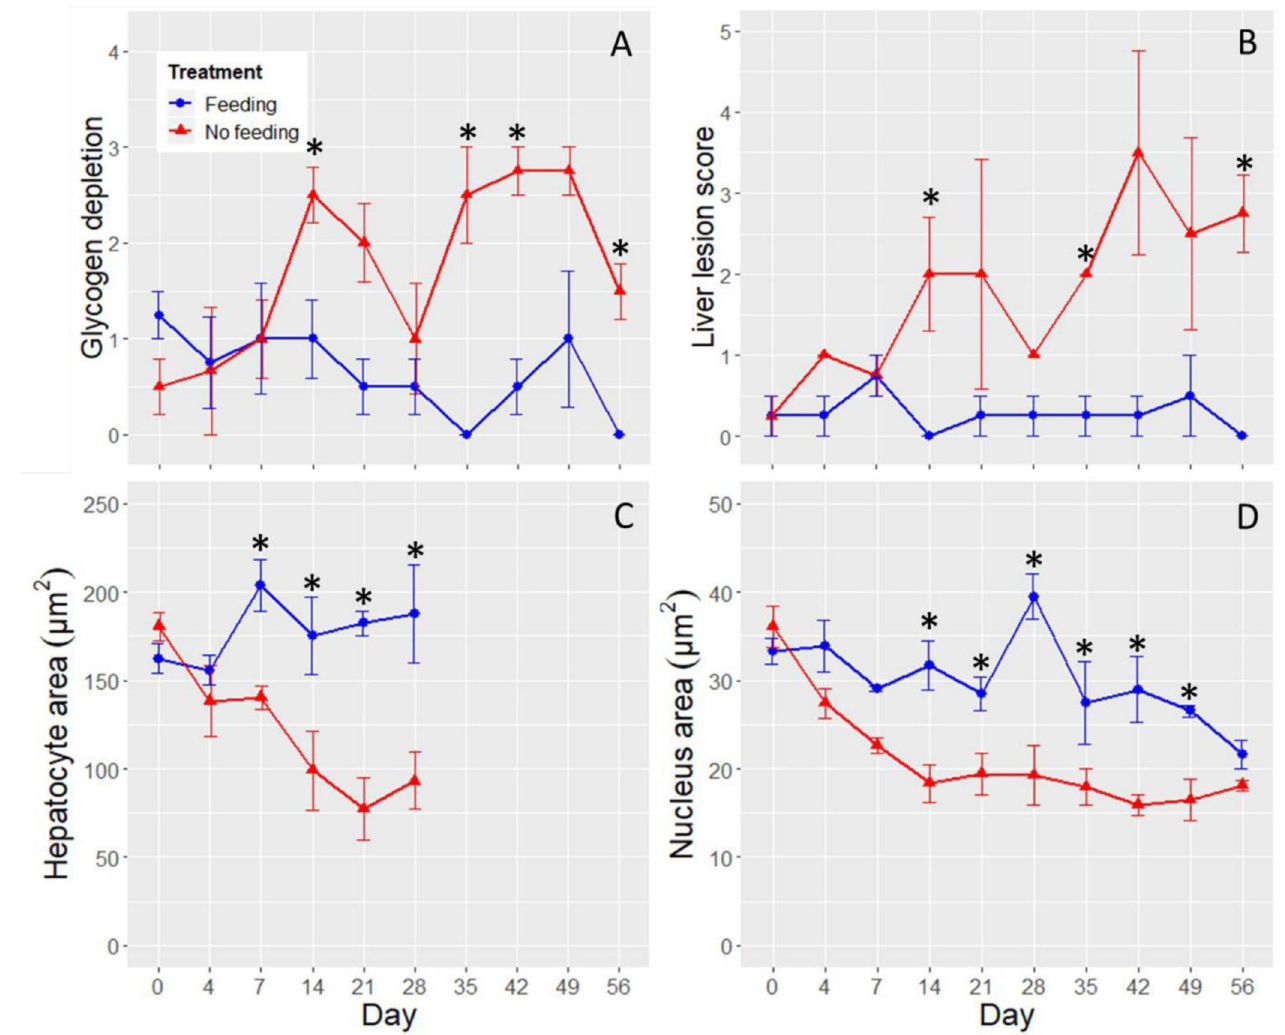
Fig 5. Histological indices by day. Panel A is glycogen depletion, panel B is liver lesion score, panel C is hepatocyte area, and panel D is nucleus area for the Feeding treatment (blue circles) and the No Feeding treatment (red triangles). The stars denote the time points at which significant differences were detected between the two treatments. The error bars are ± SE and the x-axis is not to